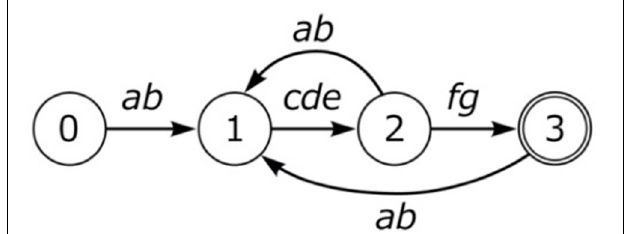
FIGURE 1 | Bengalese finch